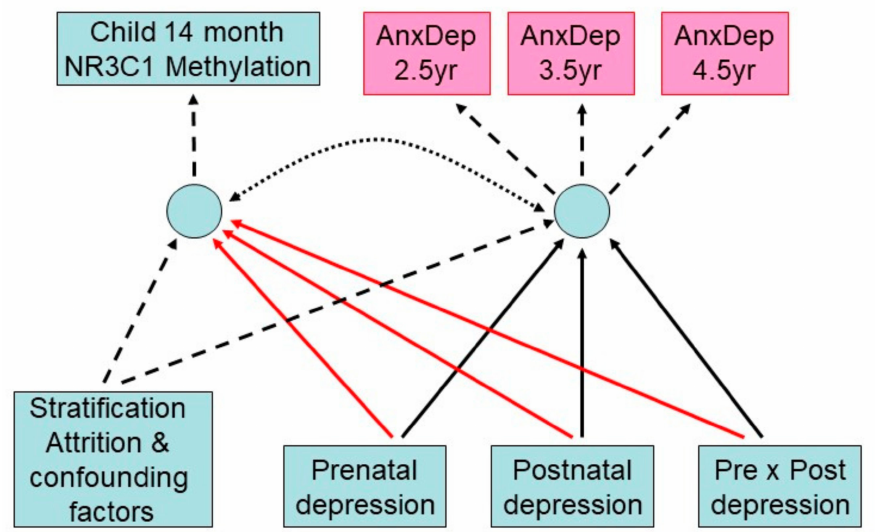
Figure 2. Structural equation model fitted to NR3C1 1-F promoter methylation at 14 months and Child Behavior Checklist (CBCL) anxious-depressed scores at ages 2.5, 3.5, and 5